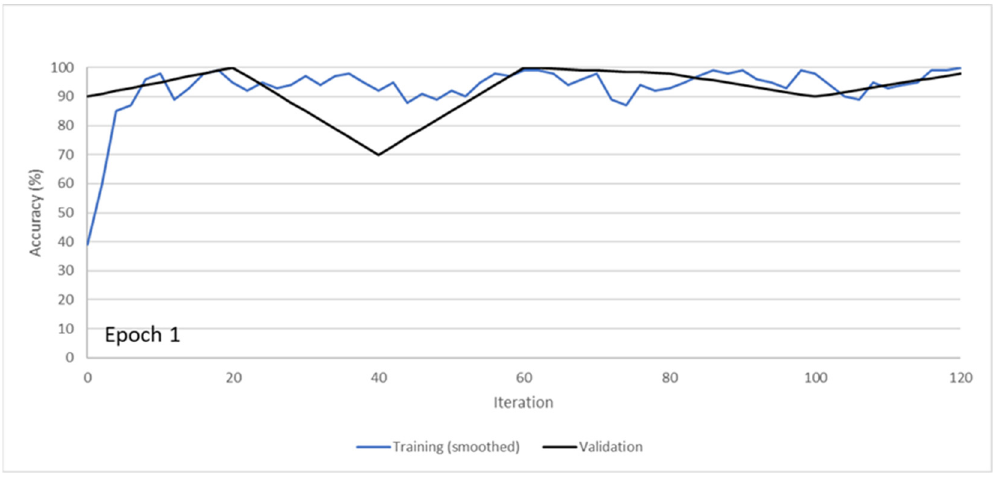
Figure 8. Custom-designed convolutional neural network training results.